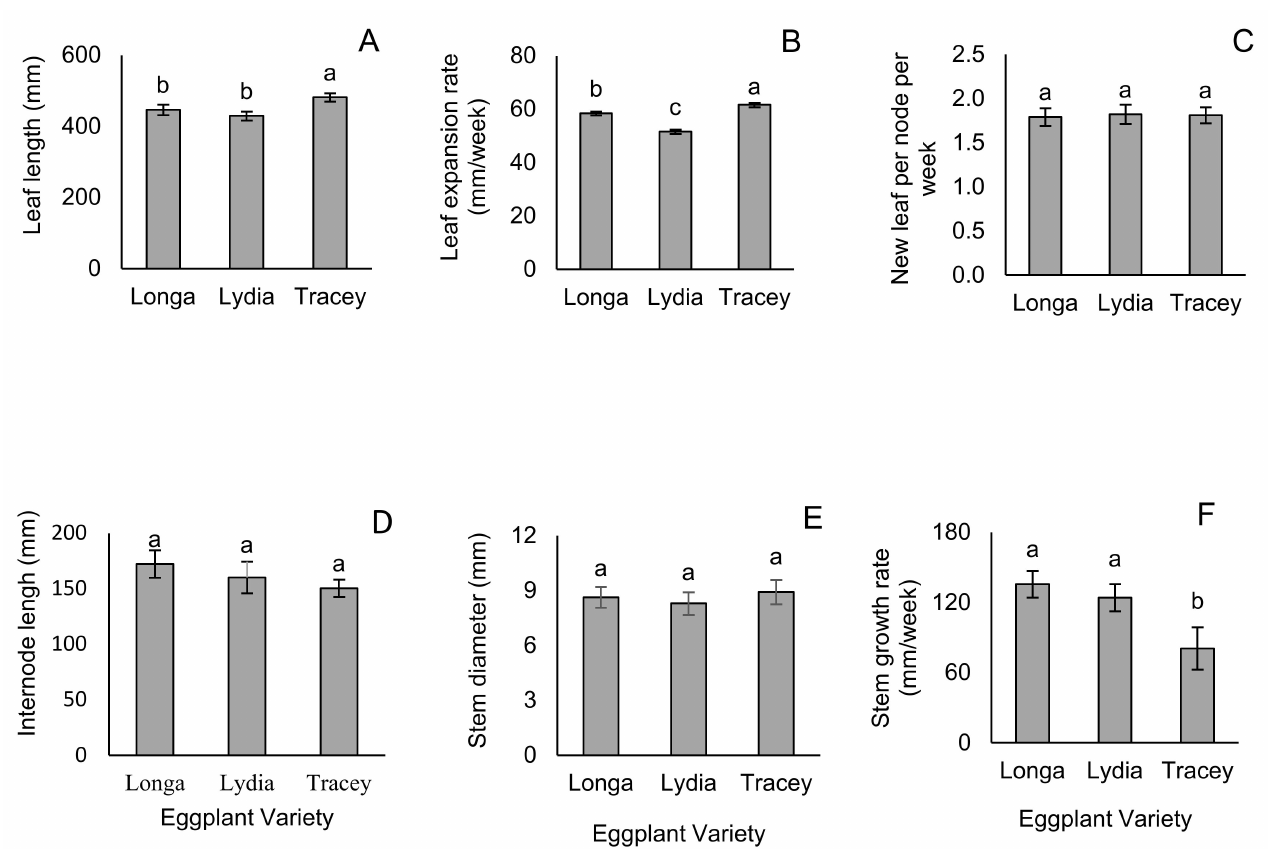
Figure 1. Leaf and stem growth properties of eggplant in the high-tech greenhouse. Leaf length ( A ), Leaf expansion rate ( B ), New leaf per node ( C ) Internode length ( D ) Stem diameter ( E ), and Stem growth rate ( F ). Data are averaged over 21 weeks of measurements with 30 biological replicates for each cultivar per week. Different lowercase letters indicate statistical significance at p < 0.05.